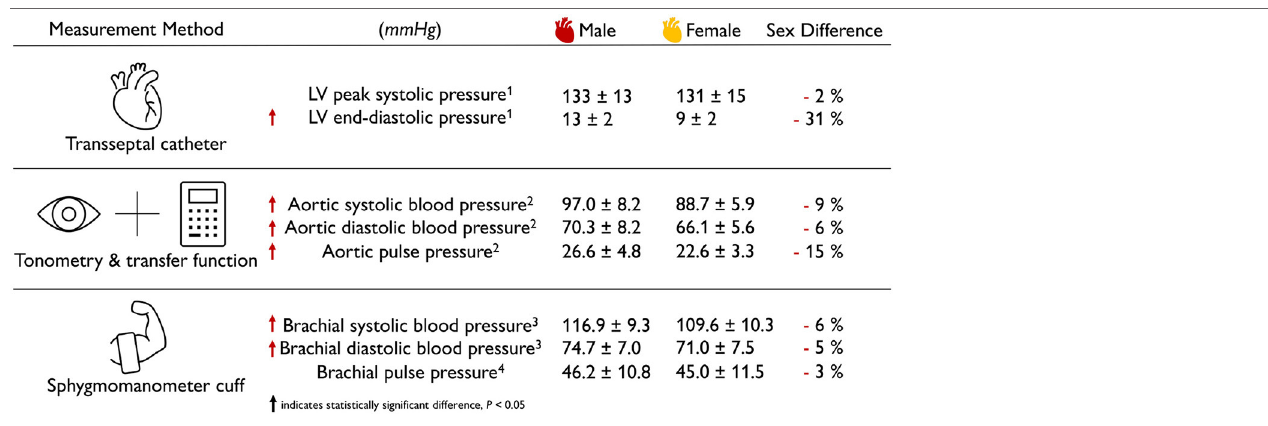
Sex differences between female and male blood pressures in percent, with the male heart as the baseline. With the use of the transseptal catheter, the most invasive blood pressure measuring technique, the male heart is shown to have significantly greater end-diastolic pressure than the female heart, there was no significant difference for systolic pressure. With less invasive techniques, the differences between male and female blood pressure were between 5–15%, with the male pressure always greater than the female. Negative values in red indicate that the female parameter is smaller; arrows indicate reported statistically significant differences; quantitative data are represented as mean absolute value ± SD; [1] Villari et